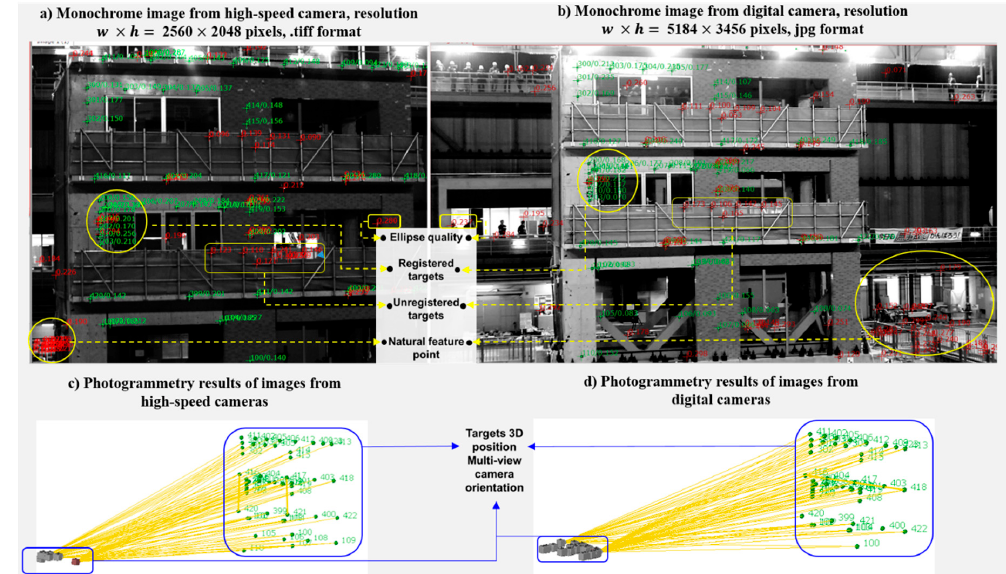
Figure 2. Example of photogrammetry images with typical output; monochrome images captured from a three-story building seismic test monitored using high-speed and digital cameras, and respective photogrammetry results for 3D positions and rays of optical targets in object coordinates.